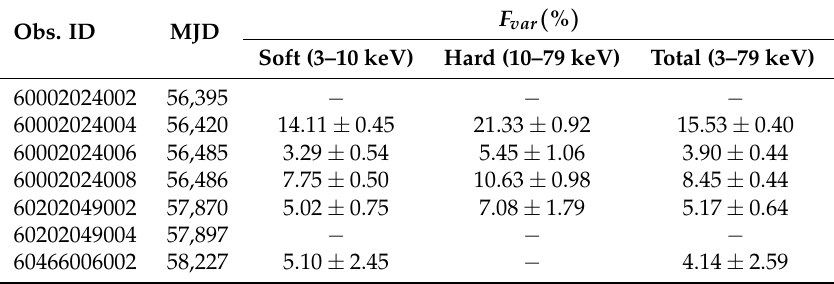
Table 2. Hard X-ray variability properties of Mrk